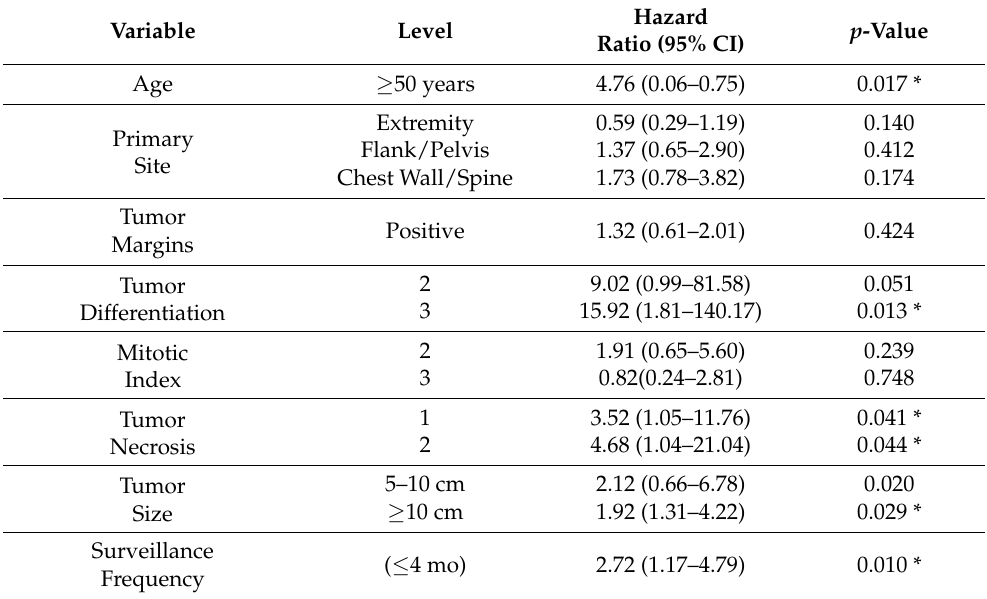
Table 3. Multivariate Analysis of Prognostic Factors for Overall Survival. * indicate significant results, p -value < 0.05.